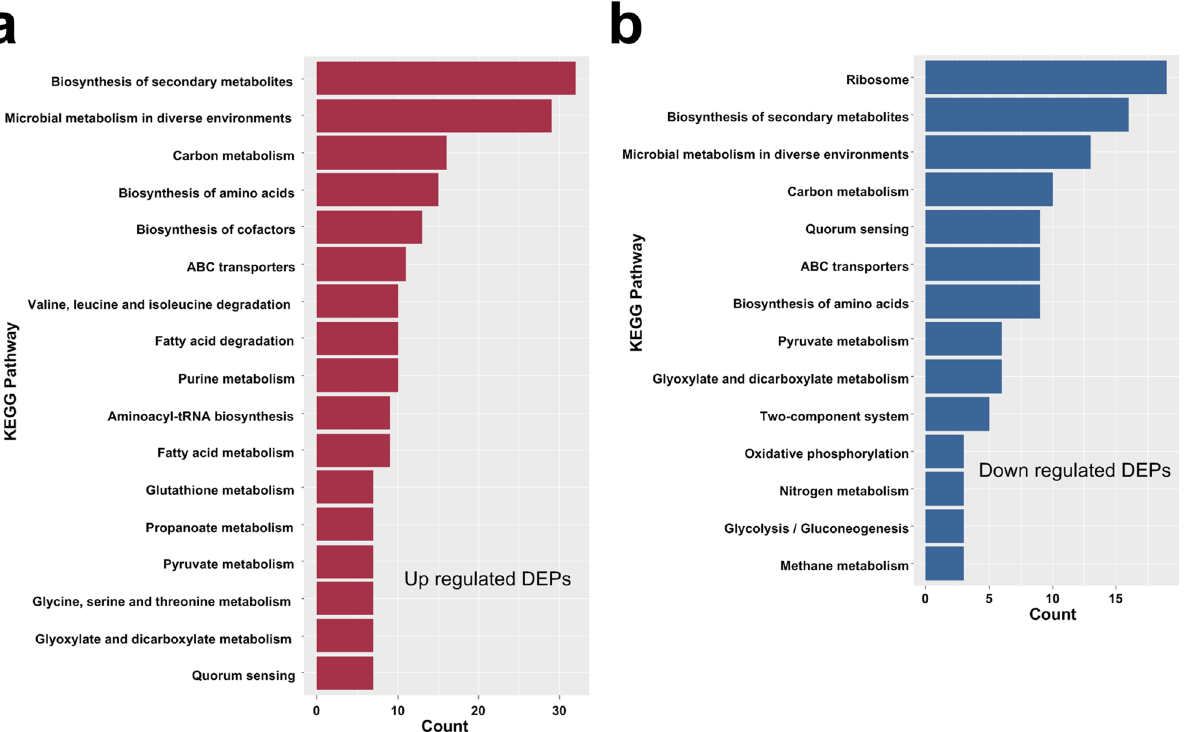
Figure 4. Bar graph of KEGG enrichment analysis. ( a ) Most enriched KEGG pathways of up-regulated DEPs in 3AB group and 3ABCon group. ( b ) Most enriched KEGG pathways of down-regulated DEPs in 3ABgroup and 3ABCon